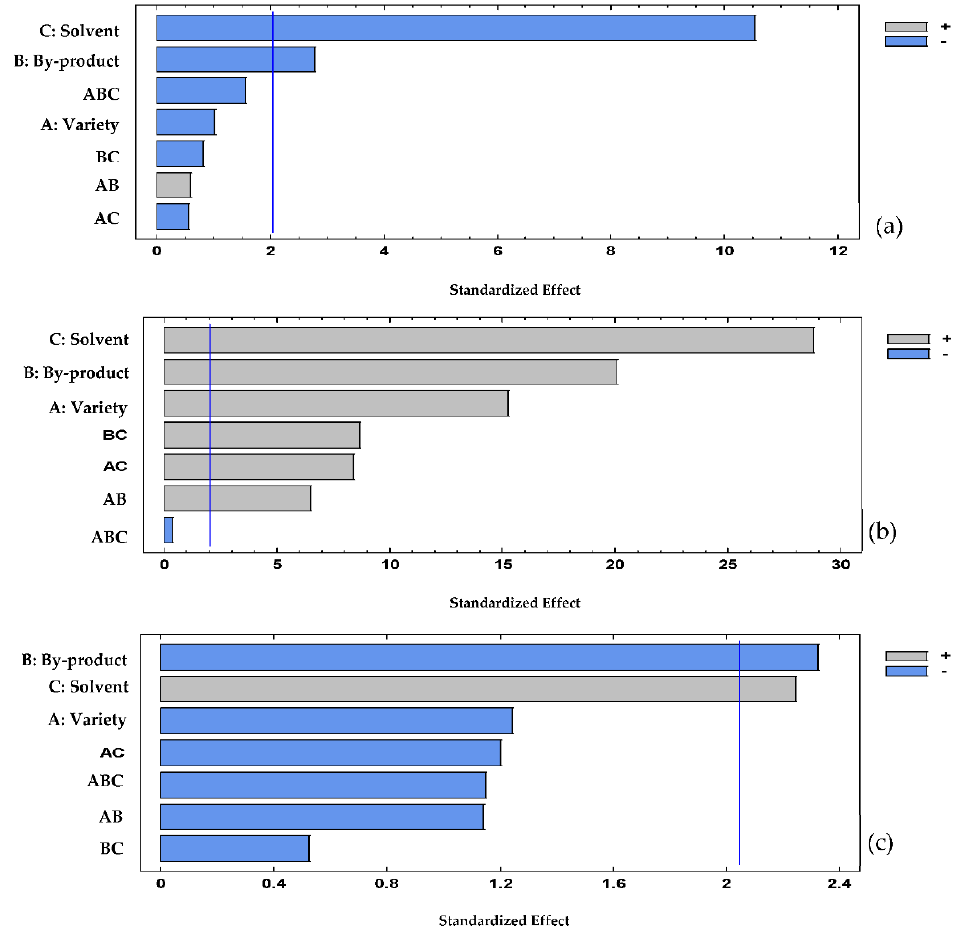
Figure 1. Pareto chart: ( a ) total polyphenol content, ( b ) DPPH ( c ) and ABTS.